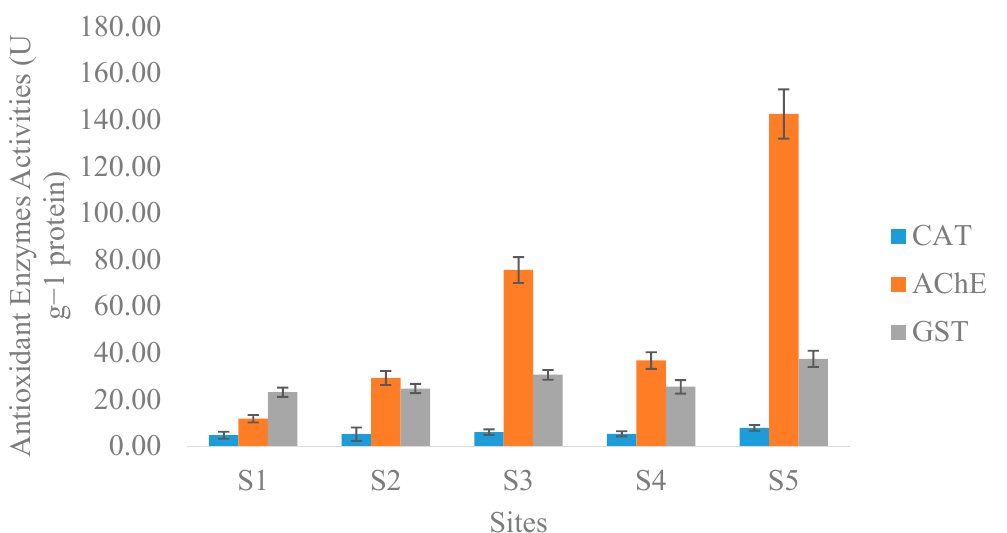
Figure 5. Antioxidant enzymes activities in freshwater snail. CAT = Catalase, AChE = Acetylcholinesterase, GST = Glutathione-S-transferase.